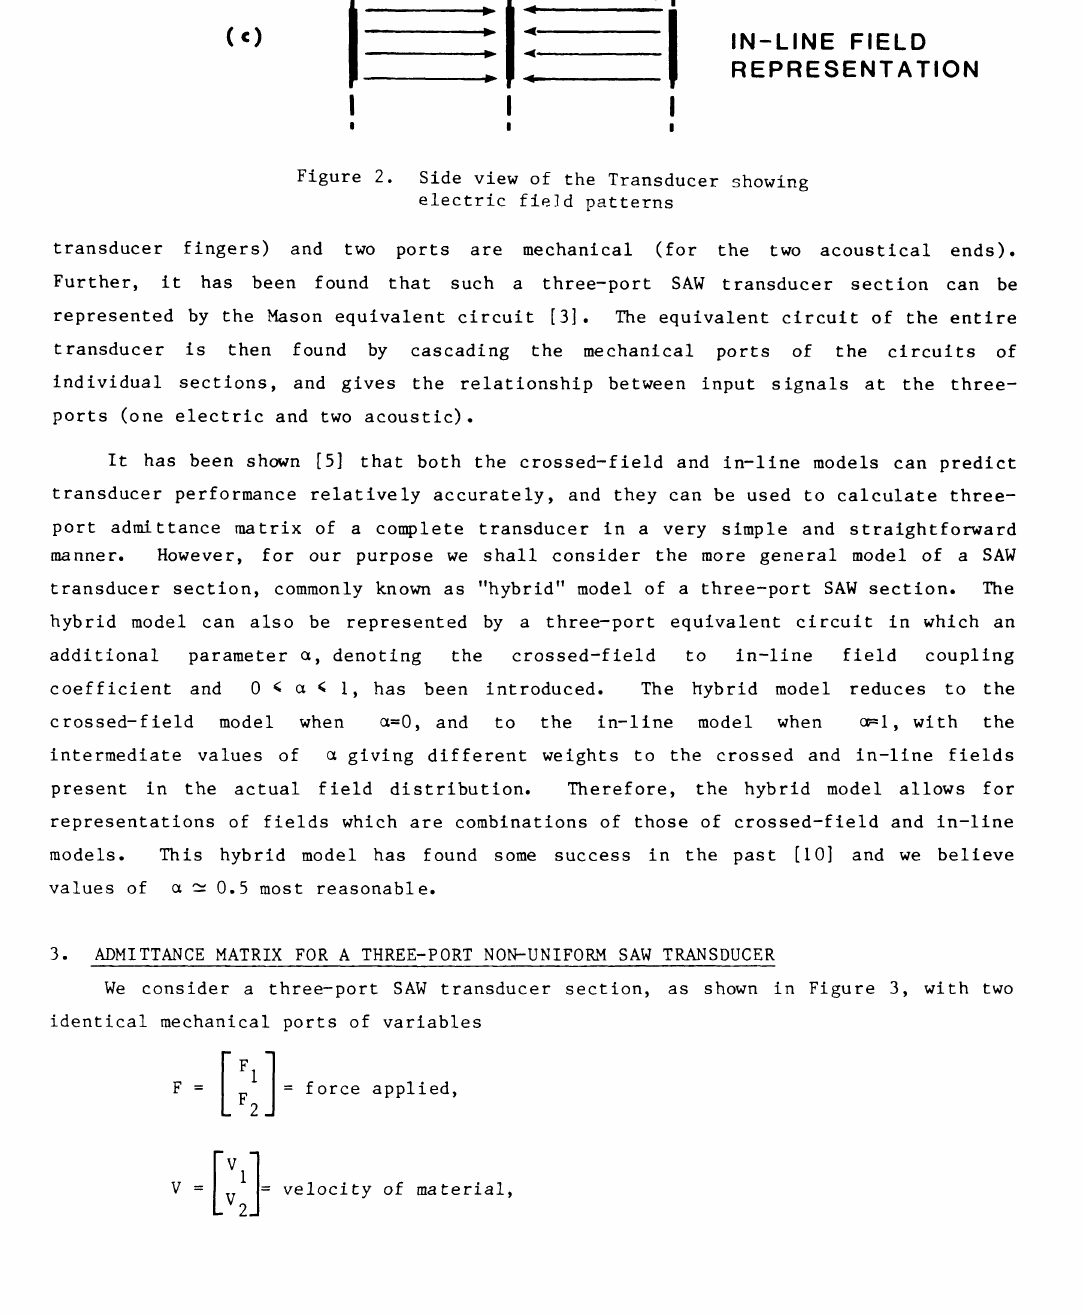
Figure 2. Side view of the Transducer showing electric field